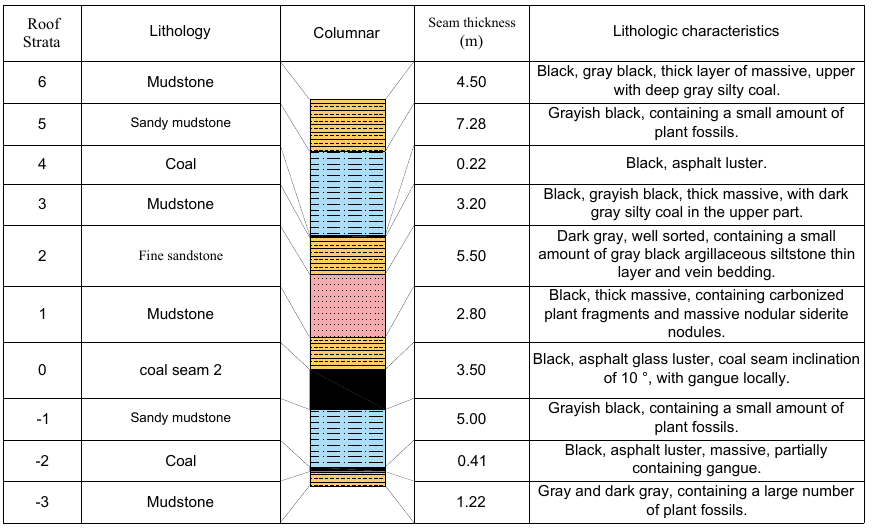
Figure 16. Comprehensive histogram of No. 2 coal strata. Working face 3204 is arranged in coal seam 2, located on the south side of the return-air downhill in mine district 3, adjacent to working face 3206 and the gob area of working face 3202. The north side of the return-air tunnel of working face 3204 is the roadway of mining district 3, the south side is the boundary of mining district 3, the west side is a solid coal seam, and the east side is a 30 m section protection coal pillar and the gob of working face 3202. Figure 17 shows the layout of the roadway.